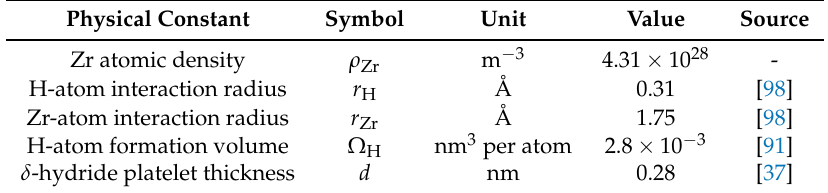
a in α -Zr, which is equal to (cid:104) (cid:105)